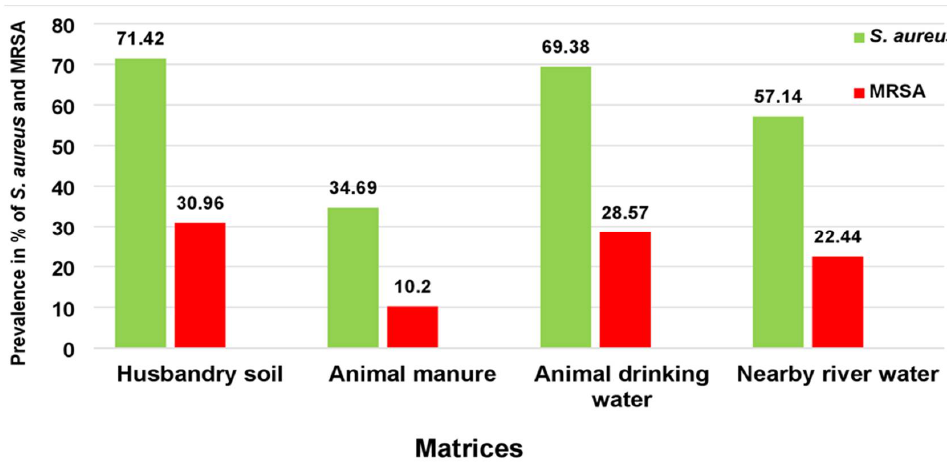
Figure 1. The prevalence of culture-positive samples for S. aureus compared to the MRSA culture- positive samples per sample matrix. positive samples per sample